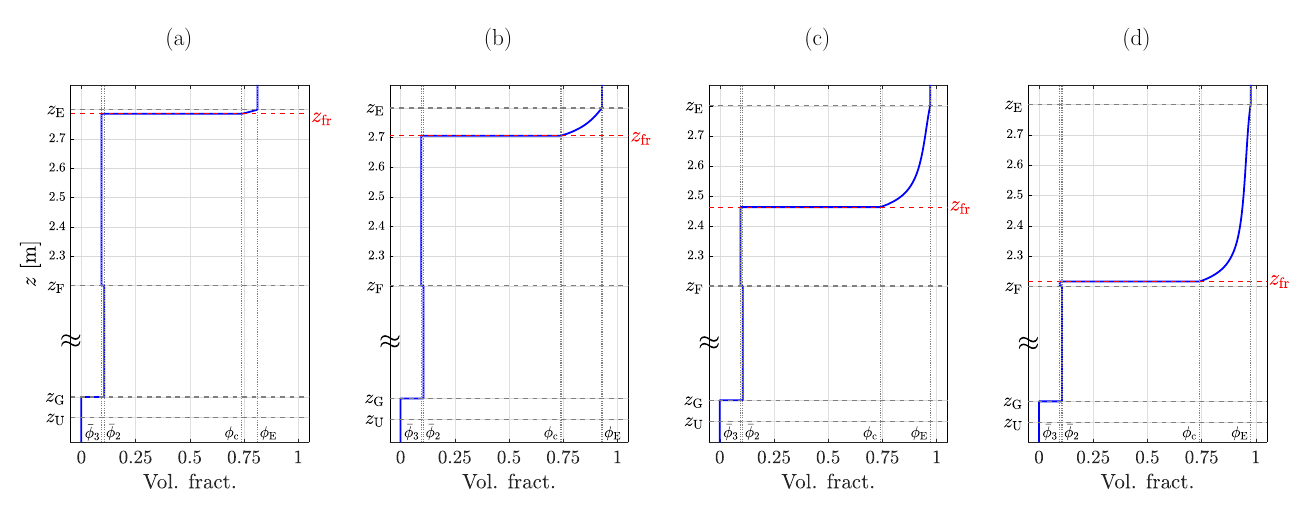
Figure 7. Examples of desired steady states for the gas phase, given by (28). To obtain these fig- ures, we used fixed values of φ G = 1, φ F = 0, q U = 1cm/s, q G = 1.3cm/s and q W = 0cm/s, and we varied q F , choosing: ( a ) q F = 1.3cm/s, ( b ) q F = 1.1cm/s, ( c ) q F = 1.04cm/s and ( d ) q F = 1.032cm/s. With these values for the volumetric flows, we obtained a pulp–froth in- terface located at ( a ) z fr = 2.7856m, ( b ) z fr = 2.7062m, ( c ) z fr = 2.4628m and ( d ) z fr = 2.2155m, respectively, and an effluent volumetric fraction of ( a ) φ E = 0.8125, ( b ) φ E = 0.9286, ( c ) φ E = 0.9701 and ( d ) φ E = 0.9760.